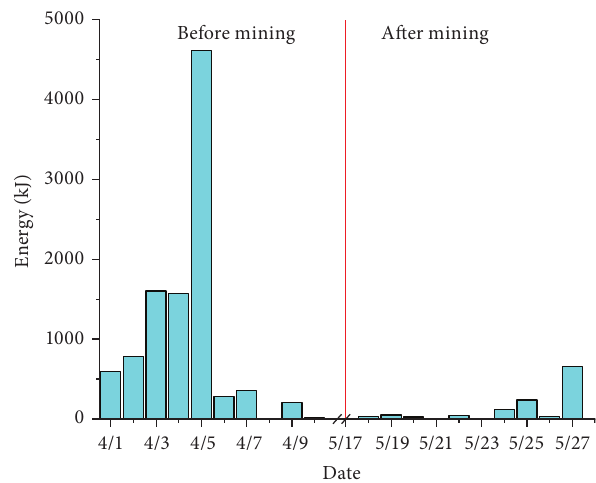
Figure 6: Energy comparison graph of microseismic events before and after mining. Figure 7 is a graph of cumulative energy and cumulative events. It can be seen from Figure 7 that the cumulative number of microseismic events is higher after mining, but in terms of cumulative energy of microseisms, the large-size weak zone was affected by the geological tectonic movement resulting in the dislocation of the large-size weak zone before